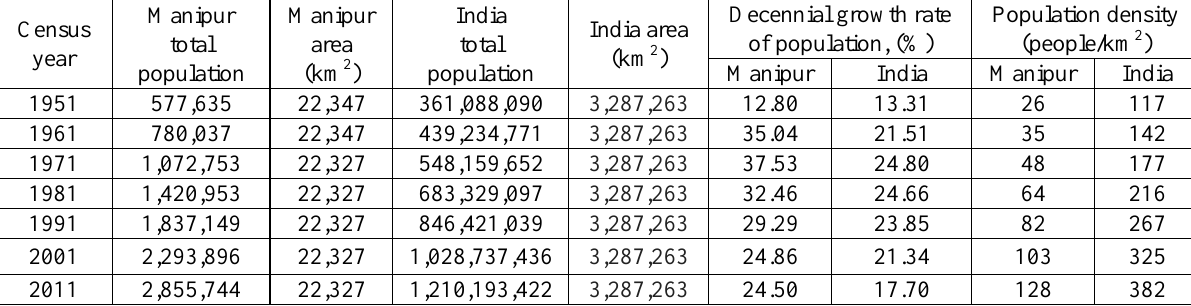
Table 3. Growth of population in Manipur vis-a-vis India during 1951 to 2011 [23 -